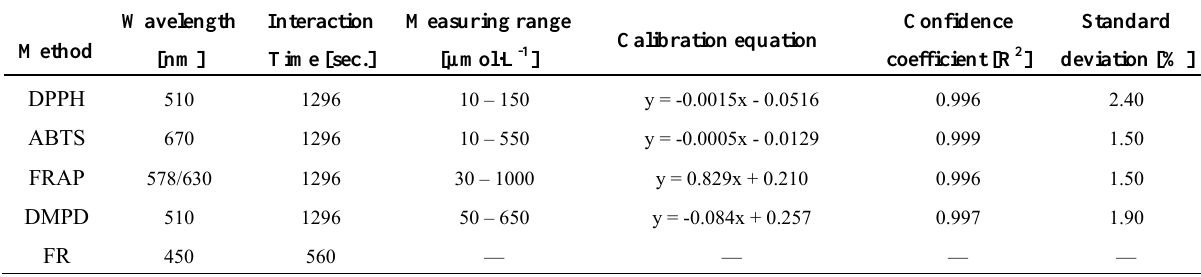
Table 2. Summarization of the parameters for individual methods related to the standard of Trolox ® (n = 5).